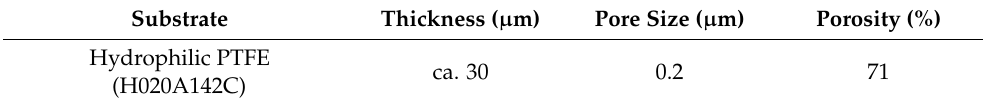
Table 1. Specifications of porous PTFE substrate utilized for preparing PFPEM in this work.